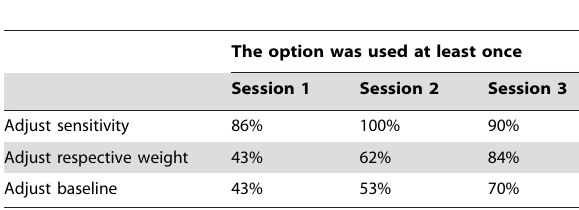
Table 5. Use of the available controls at least once during a session by the coaches.